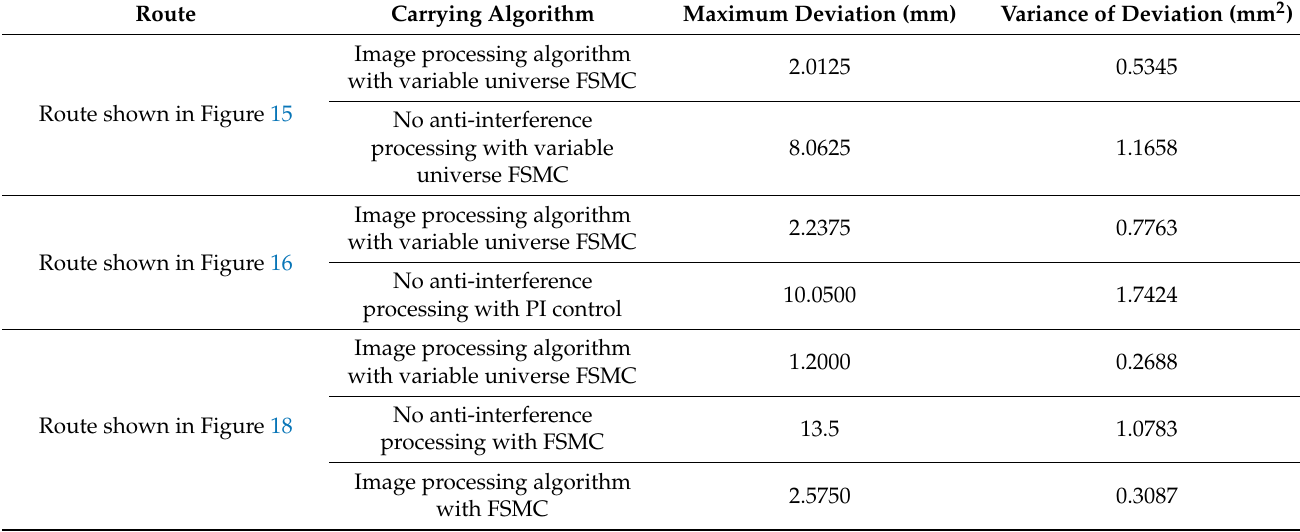
Table 2. Comprehensive performance test